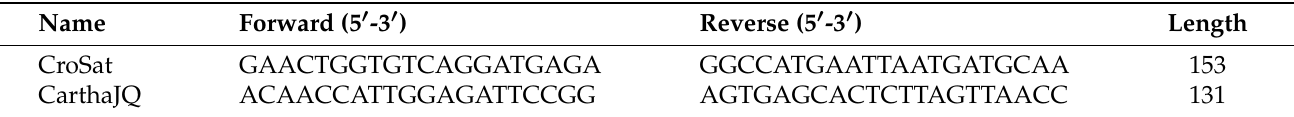
Table 1. Sequences and amplicon lengths of primers used in this study. Amplicon length for Crosat and CarthaJQ was estimated from the sequences with Genbank accession number HE663909 and JQ952667 respectively.